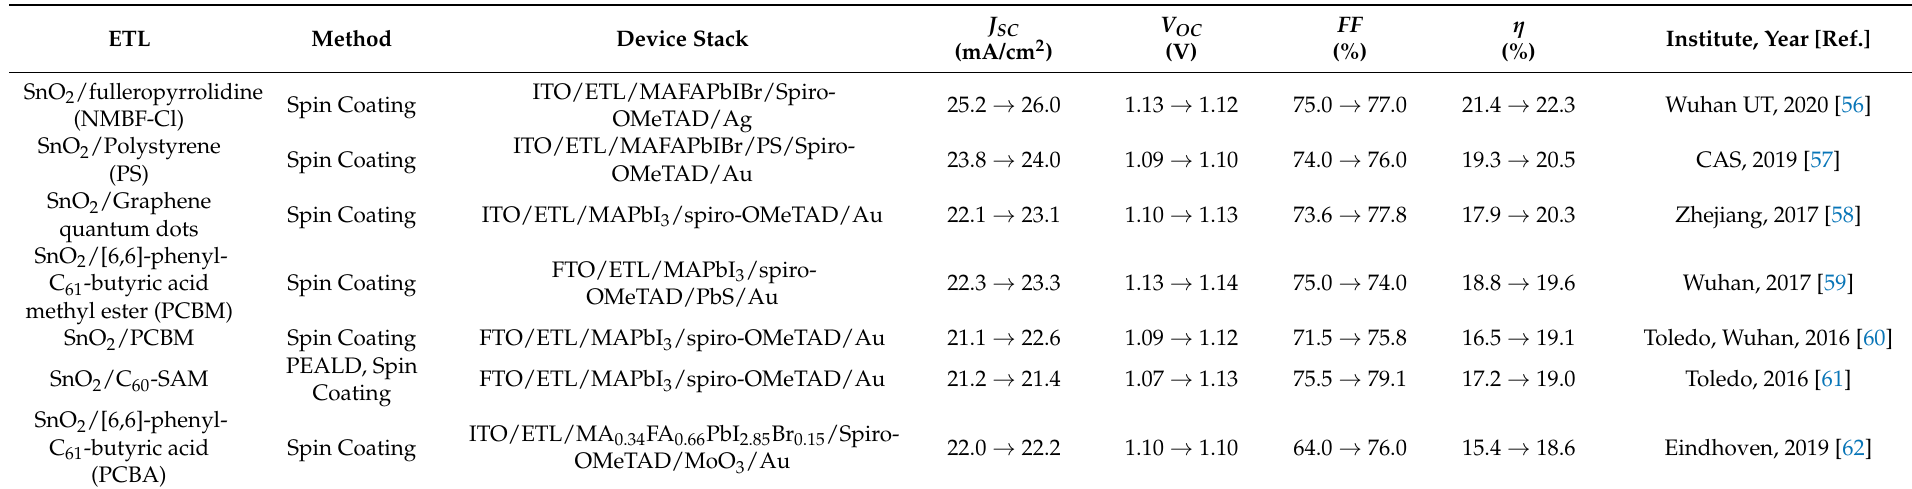
Table 5. Summary of perovskite-solar cells based on surface modification of SnO 2 ETL by carbon